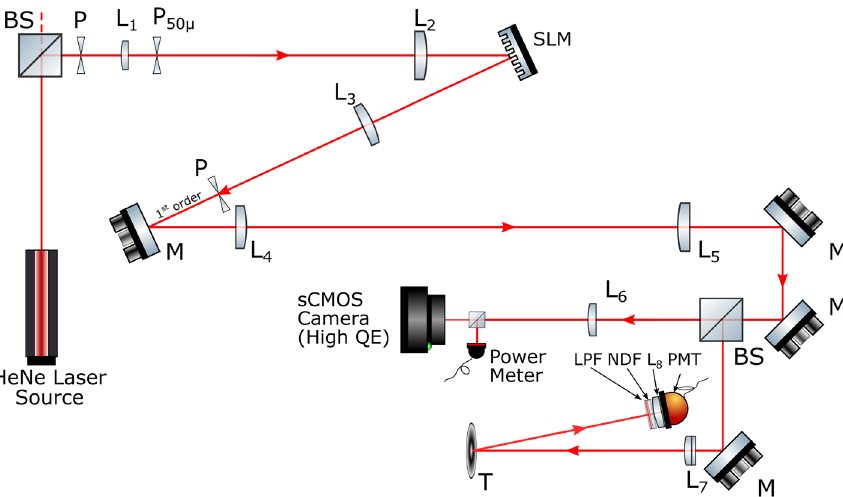
Figure 1. The output of the HeNe laser encounters a polarising beamsplitter that propagates the vertically polarised, reflected light in the direction of the spatial light modulator (SLM). The beam magnified and spatially filtered as it passes through a pinhole (P), a 50 mm focal length lens (L 1 ), a 50 µ m precision pinhole (P 50 µ ) and a 400 mm focal length lens (L 2 ). The beam is modulated with Hadamard matrices displayed on a custom liquid- crystal SLM (Meadowlark Optics). The modulated light from the SLM is focused at an aperture (P) by 250 mm focal length lens (L 3 ) where the first order of diffracted light is selected. The light is subsequently propagated into the far-field through a 250 mm focal length lens (L 4 ) and a 400 mm focal length lens (L 5 ). The beam is propagated into two separate arms. One arm uses a power meter to measure the laser power and an ORCA- Flash CMOS Hamamatsu camera that images the illumination pattern. The second arm consists of the target (T) of which light is reflected towards an arrangement of a long pass filter (LPF), neutral density filters (NDF), an 80 mm focal length lens (L 8 ) and a Thorlabs photomultiplier tube (PMT, model PMM02), completing the single- pixel